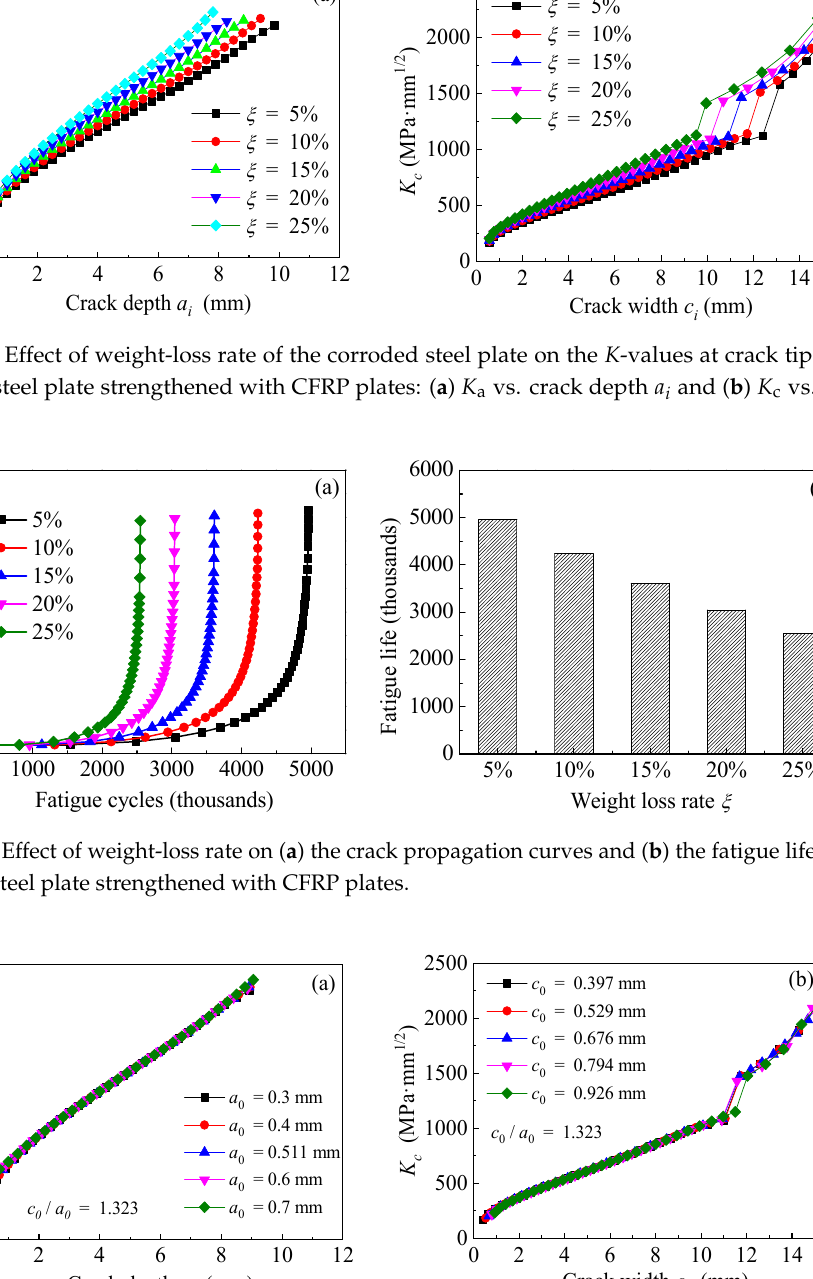
Figure 19. Effect of equivalent initial crack size on the K -values at crack tip of the corroded steel plate strengthened with CFRP plates: ( a ) K a vs. crack depth a i , and ( b ) K c vs. crack width c i